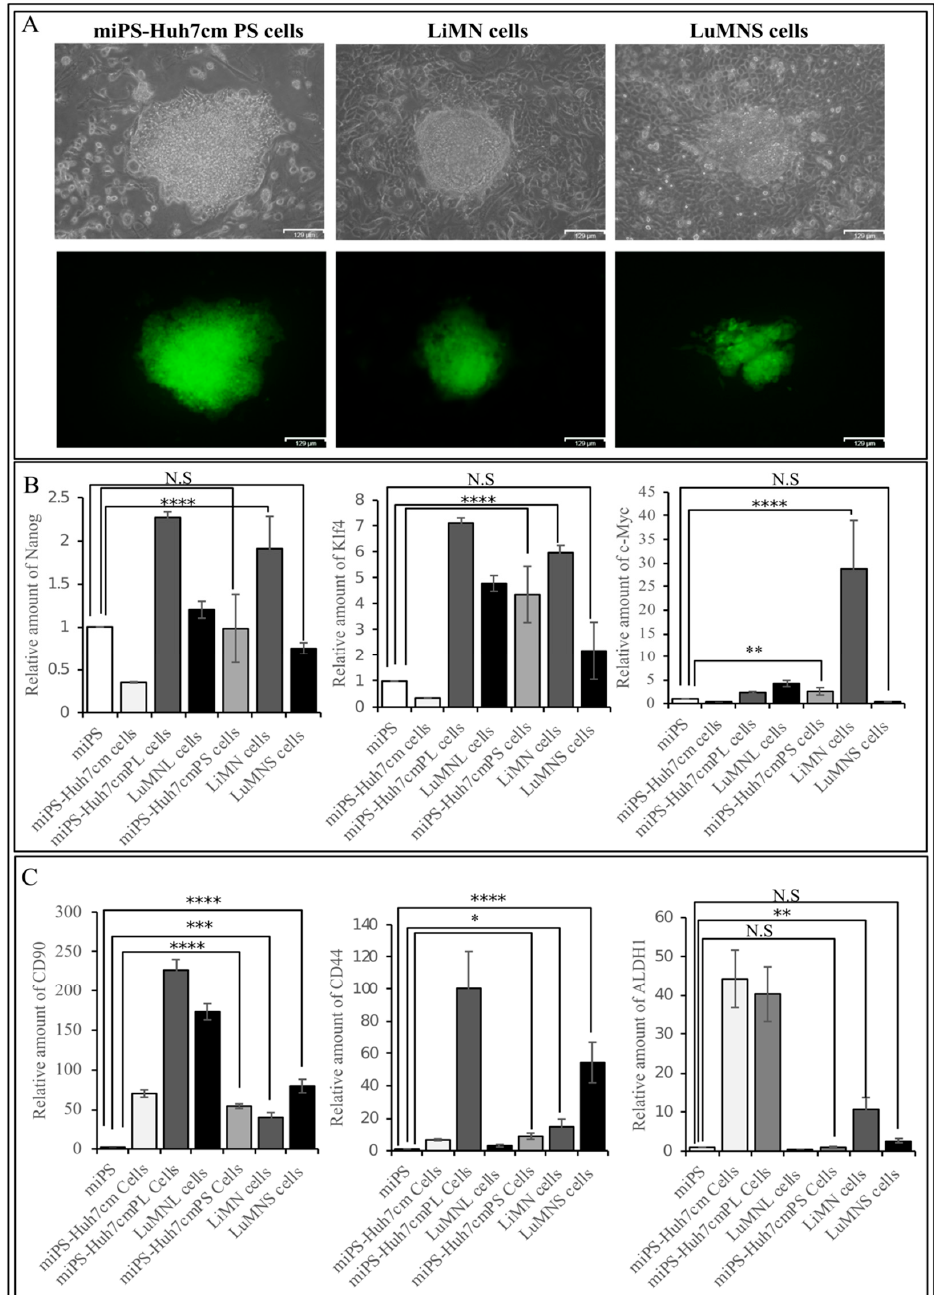
Figure 7. ( A ) Representative images for adherent cultures of miPS-Huh7cmPS cells, LiMN cells and LuMNS cells. Images show the differentiated cells and undifferentiated GFP-positive cells. Scale bars represent 129 µ m; ( B ) RT-qPCR analysis of CSC markers (CD44,CD90,ALDH1) in cells derived from intrahepatic transplantation (miPS-Huh7cmPL cells and LuMNL cells) and intrasplenic transplantation-derived cells (miPS-Huh7cmPS cells, LiMN cells and LuMNS cells) in comparison with miPS-Huh7cm cells and miPS; ( C ) RT-qPCR analysis of stemness markers (Nanog, Klf4 and c-Myc) in cells derived from intrahepatic transplantation (miPS-Huh7cmPL cells and LuMNL cells) and intrasplenic transplantation-derived cells (miPS-Huh7cmPS cells, LiMN cells and LuMNS cells) in comparison with miPS-Huh7cm cells and miPS (* p < 0.01, ** p < 0.001, *** p < 0.0001, **** p < 0.00001).